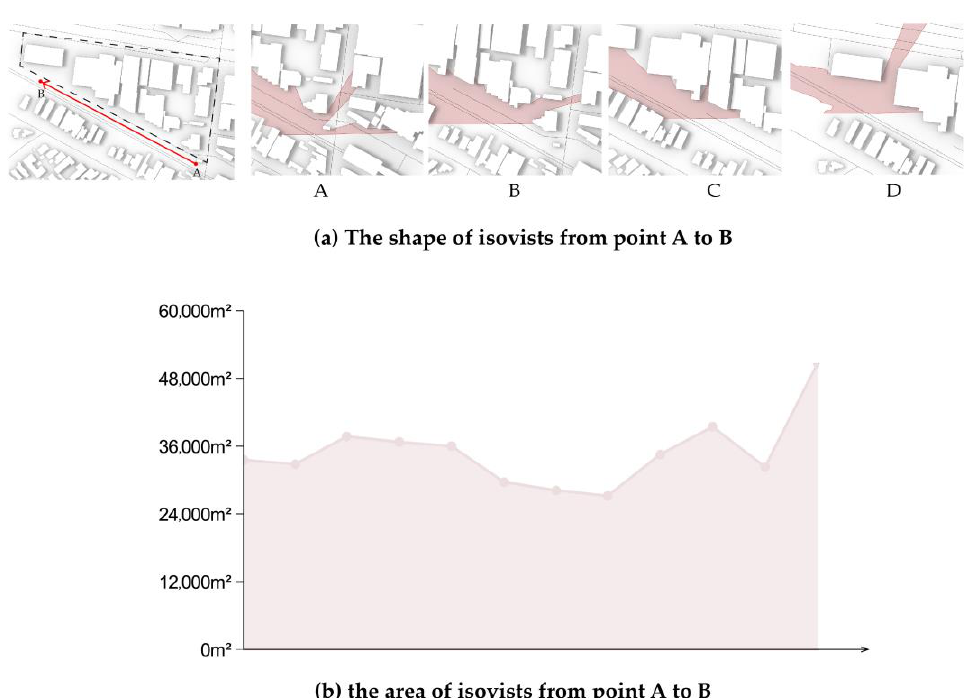
Figure 8. Visual experience analysis of the renewal site.